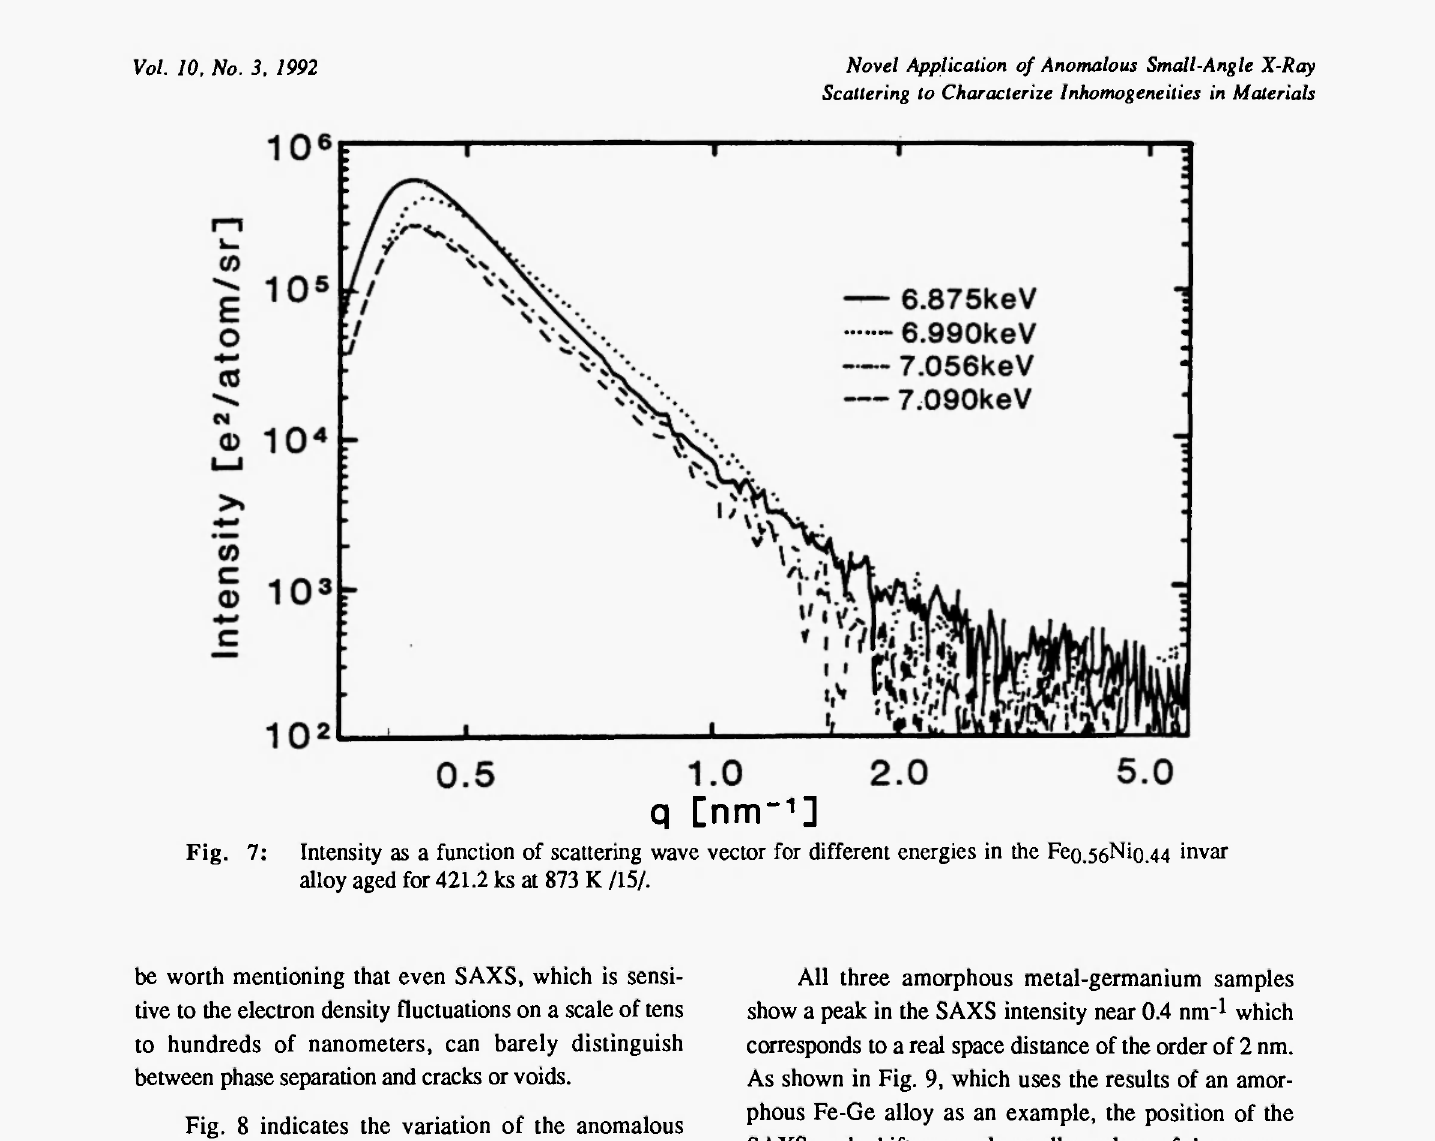
Fig. 7: Intensity as a function of scattering wave vector for different energies in the Feo.56Nio.44 invar alloy aged for 421.2 ks at 873 Κ